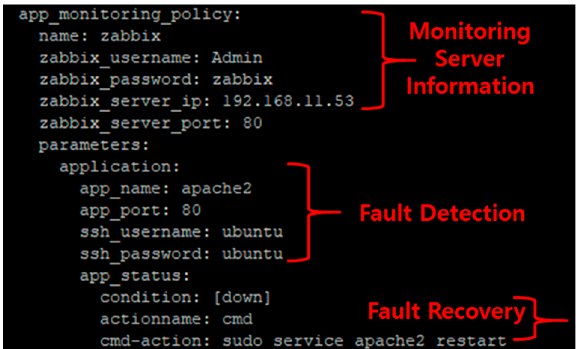
Figure 8. Example of VNF registration information.